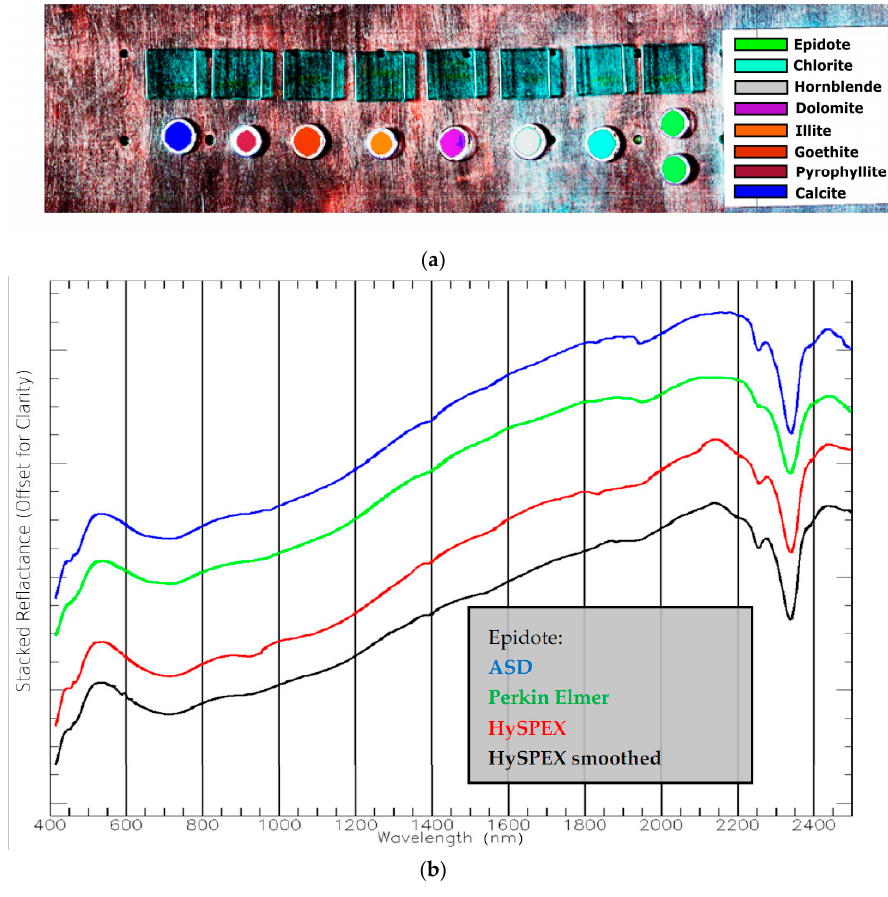
Figure 11. ( a ) False colour HySPEX image (Red 2210.02 nm, Green 800.295 nm, Blue 651.19 nm) overlain with classification of EnGeoMAP [1], ( b ) Epidote spectra from different spectrometers—‘HySPEX’ spectrum as spatial average of 10 × 10 pixel spectra, ‘HySPEX smoothed’ Gaussian smoothed spectrum (black).